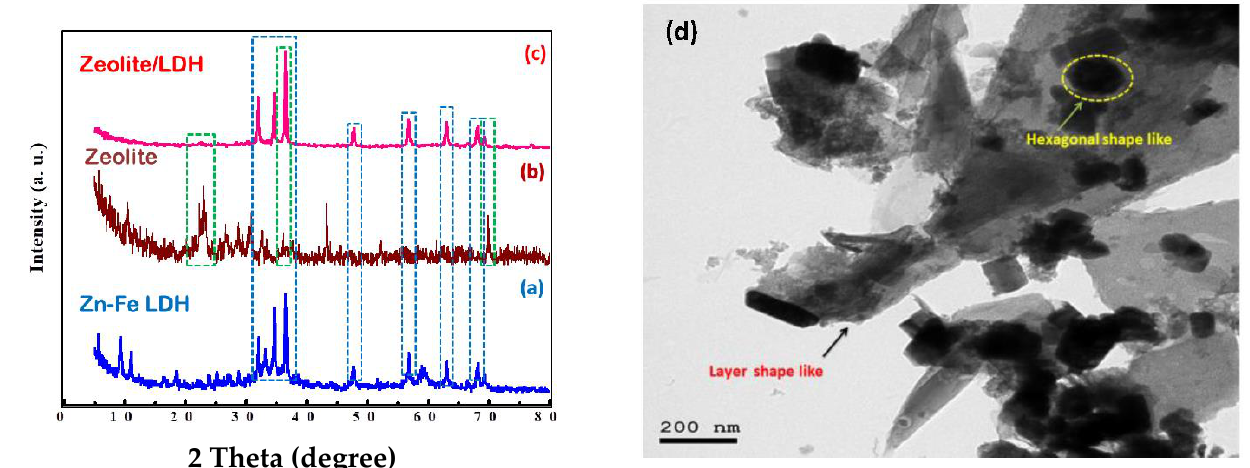
Figure 2. XRD patterns of the prepared samples ( a – c ); the HRTEM of Zn-Fe LDH ( d ). Figure 3a–c show the FT-IR spectra of the Zn-Fe LDH, zeolite, and zeolite/Zn-Fe LDH composite, respectively. Similar spectra were observed for the three materials. The FT-IR spectrum of Zn-Fe LDH (Figure 3a) presents a typical band at 1357 cm − 1 confirming the presence of NO 3 − 1 groups. It also shows a sharp peak at 1650 cm − 1 and a broad peak at 3400 cm − 1 , which were attributed to the stretching mode of the OH- group of water molecules into the interlayer of LDH, and the broadness of such a band signals a variety of hydrogen bonds at the Zn-Fe LDH surface [16]. It is clear that water has different absorption bands in zeolite materials. The strong bands at 3400 and 1630 cm − 1 were assigned to vibration of the bonds O–H-O and the bending mode of water [44]. The band at 437 cm − 1 was assigned to the bending vibration of O–Al–O and O–Si–O bonds [30,44]. Bands in the region 500–800 cm − 1 are probably due to pseudo-lattice vibrations and show the nature of the channel cations [45]. These spectra confirm the incorporation of zeolite into the Zn-Fe LDH structure. The bands appearing in the range of 1000–400 cm − 1 are due to the stretching and bending modes of Zn–O and Fe–O bonds [35]. In the spectra of zeolite and zeolite/Zn-Fe LDH, the band at 3490 cm − 1 was attributed to the Al–OH group on the surface of zeolite and the Si–OH group [30] (Figure 3b). The strong band at 1045 cm − 1 is related to the M –O ( M = Si or Al) stretching vibration [45] These spectra confirm the incorporation of zeolite into the Zn-Fe LDH structure.